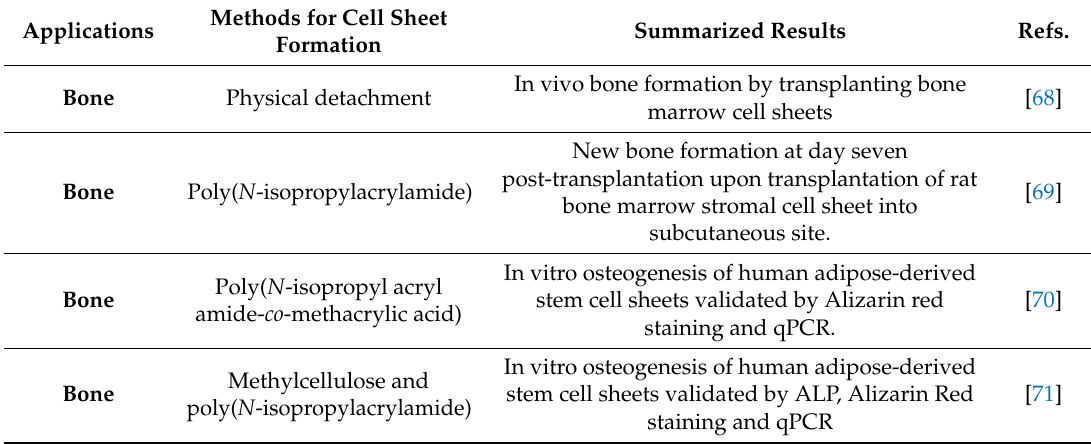
Table 1. Various applications of cell sheet-based technology for treating bone, periodontal, skin, and vascularized